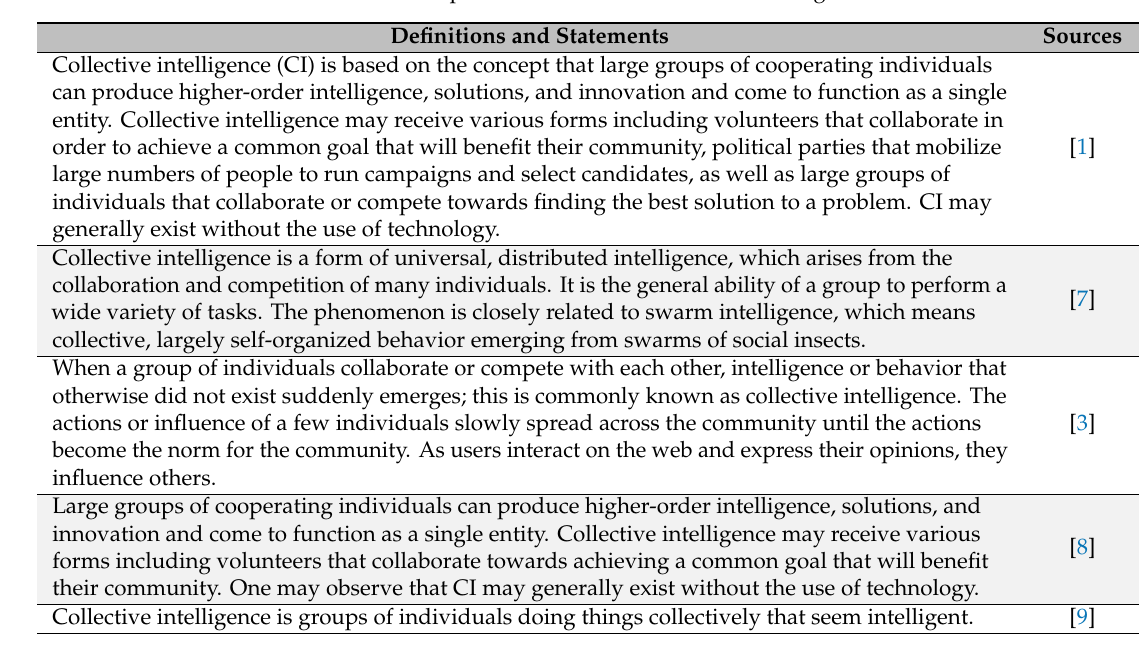
Table 2. Some partial definitions of collective